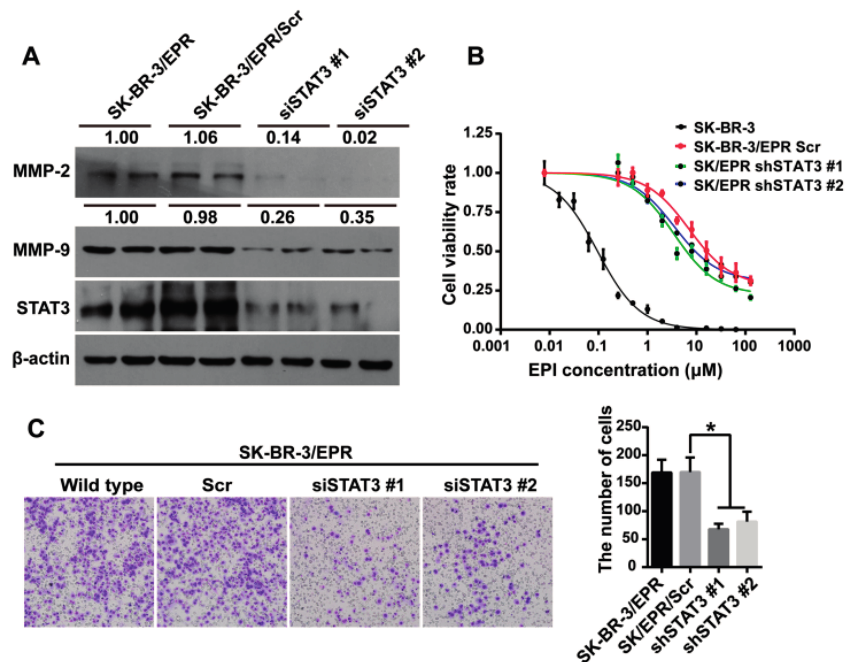
Figure 6. Knockdown of STAT3 inhibited cell invasion and downregulated expression of MMP-2 and -9 in SK-BR-3/EPR cells. ( A ) Knockdown of STAT3 significantly reduced the expression levels of MMP-2 and -9 protein in SK-BR-3/EPR cells. Western blotting analysis of STAT3, MMP-2, and -9 expression in SK-BR-3/EPR cells and SK-BR-3/EPR cells transfected with control or STAT3 specific siRNAs. The numbers above the blots show the relative values from the densitometric analysis. The levels of MMP-2 and -9 were normalized to β -actin, values are expressed as fold changes compared to SK-BR-3/EPR cells; ( B ) Knockdown of STAT3 in SK-BR-3/EPR cells slightly increased the sensitivity to epirubicin in comparison with control cells; ( C ) Knockdown of STAT3 remarkably inhibited the invasive ability of SK-BR-3/EPR cells as measured by transwell based assay (×200 magnification). * p <